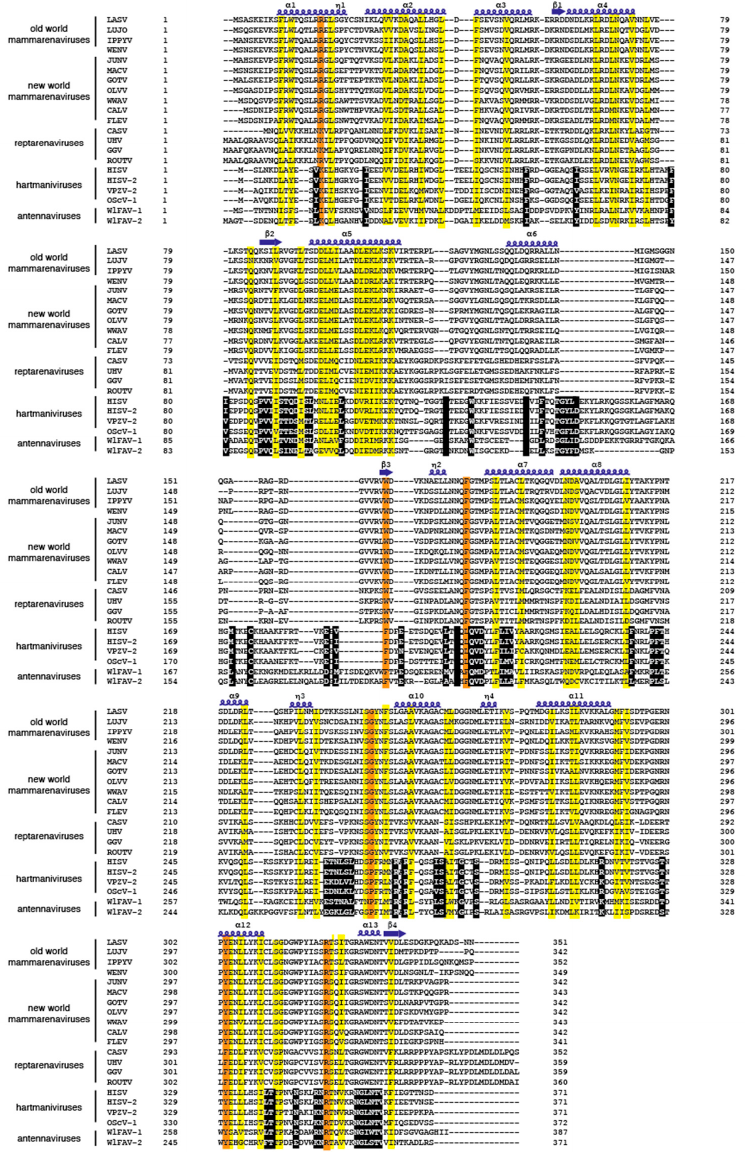
Figure 5. Amino acid sequence alignment of the N-termini of nucleoproteins from members of the four arenavirus genera. Virus abbreviations: Lassa, LASV; Lujo, LUJV; Ippy, IPPYV; Wenzhou, WENV; Junin, JUNV; Machupo, MACV; Guanarito, GOTV; Olivaros, OLLV; Whitewater Arroyo, WWAV, California (Pichinde), CALV; University of Helsinki, UHV; Golden Gate, GGV; Haartman Institute snake, HISV and HISV-2; Old Schoolhouse, OScV; W ē nl ǐ ng Frogfish arenavirus, WlFAV-1 and WlFAV-2. Residues that are conserved (identical or chemically similar) are highlighted in yellow. Conserved residues involved in RNA binding are highlighted in orange. Blue springs represent helical structures and blue arrows are beta sheets. Similar residue/sequences in antennaviruses and hartmaniviruses not present in NP of members from other genera are highlighted in black.